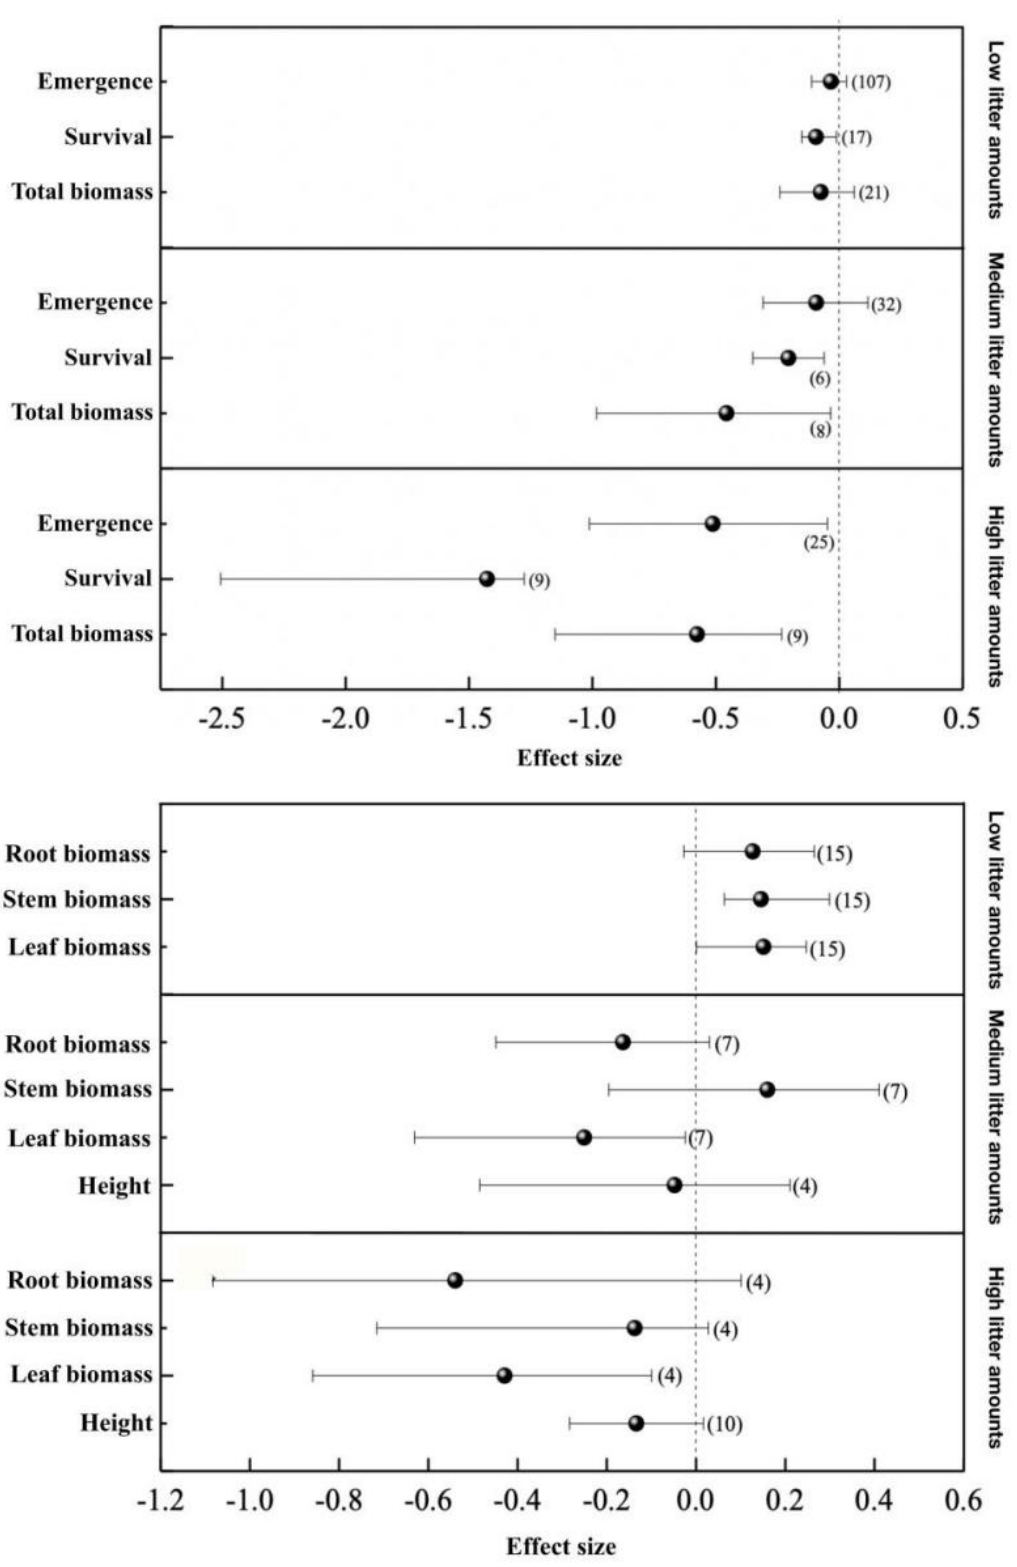
Figure 4. Mean effect size for seedling emergence, survival, total biomass, root, stem, leaf biomass, and height under low litter amounts cover (<250 g m − 2 ), medium litter amounts cover (250–500 g m − 2 ), and high litter amounts cover (>500 g m − 2 ). Error bars represent 95% CIs.